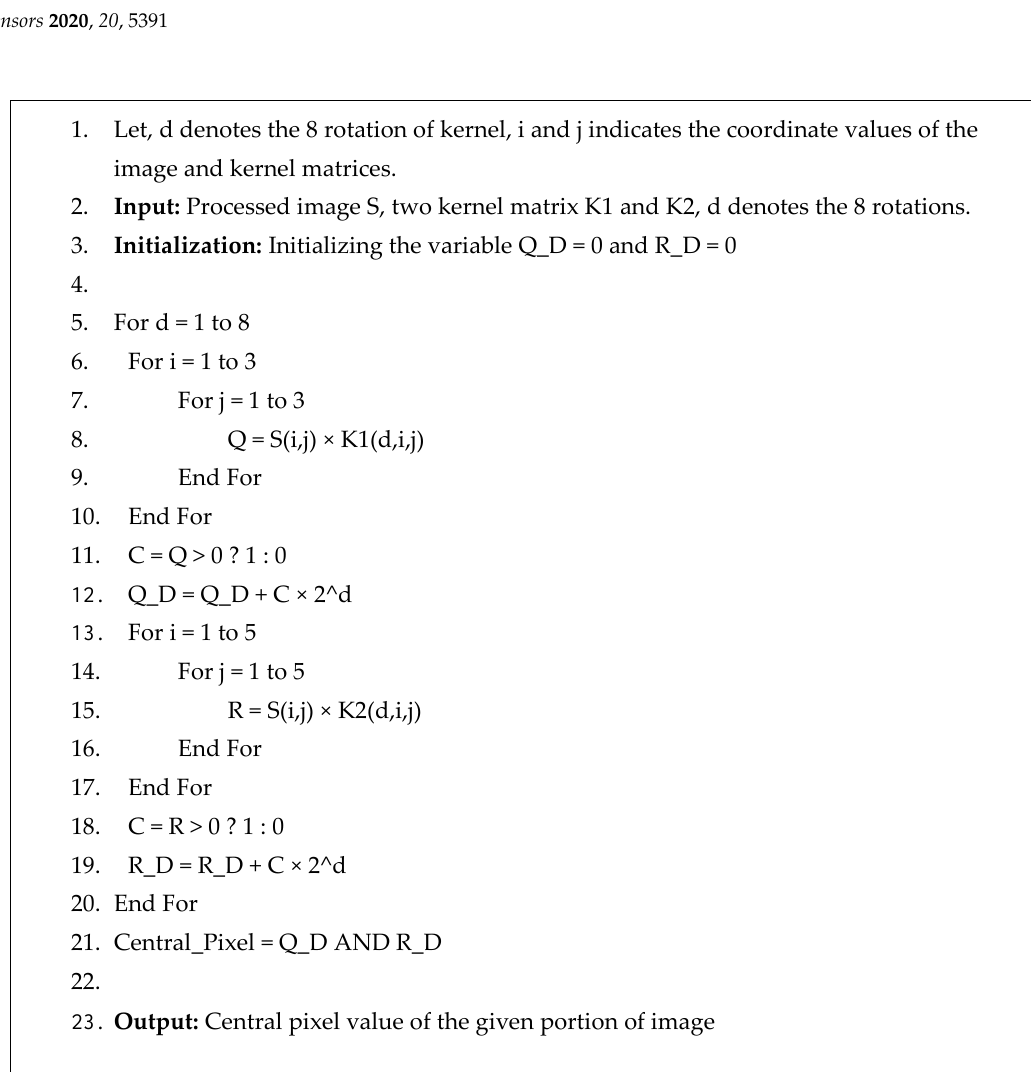
Figure 5. Feature extraction algorithm.